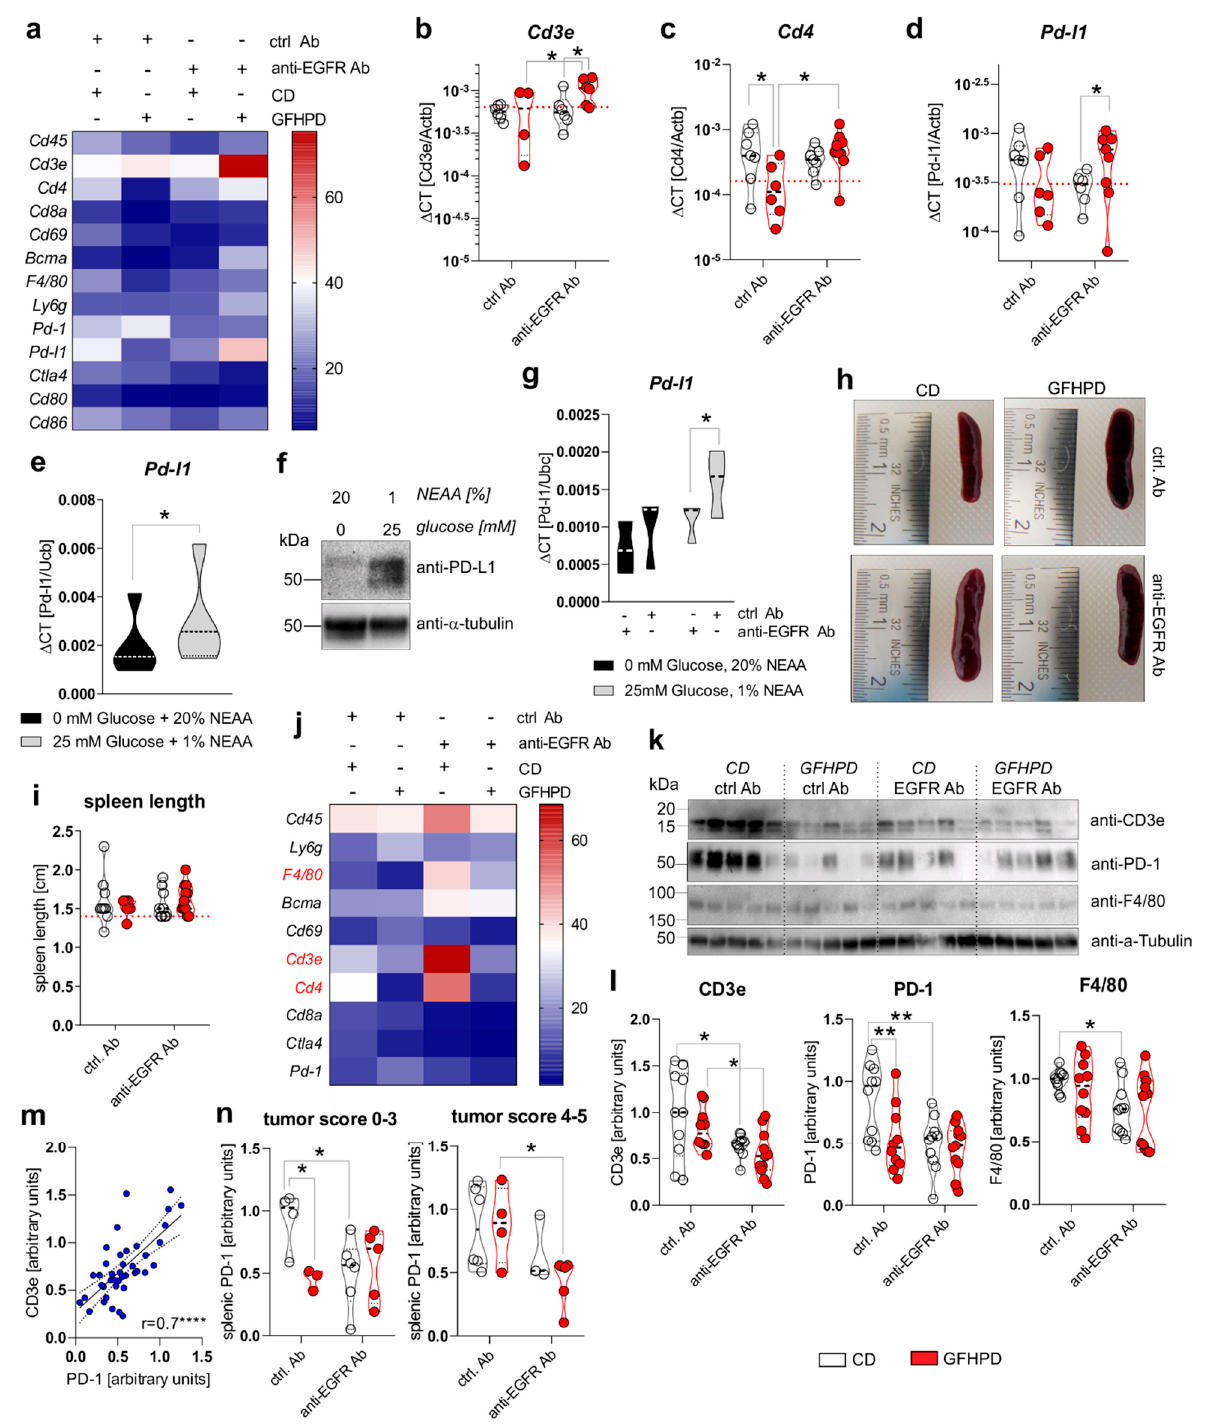
Figure 6. GFHPD and anti-EGFR Ab treatment reduce tumoral Pd-l1 expression and PD-1 expressing T cells. ( a – d ) QPCR analyses were performed to quantify mRNA expression level of Cd45 , Cd3e , Cd4 , Cd8a , Cd69 , Bcma , F4/80 , Ly6g , Pd-1 , Pd-l1 , Ctla4 , Cd80 , or Cd86 in colonic tissues collected from indicated treatment groups of AOM/DSS mice. Results are based on ∆ CT calculation including relation to β -actin mRNA expression. Heatmap was generated based on normalized values (%) per transcript. The mean value per group is presented. n = 6–7 ctrl. Ab and CD; n = 6–7 anti-EGFR Ab and CD; n = 4–6 ctrl. Ab and GFHPD; n = 6–9 anti-EGFR Ab and GFHPD. Red dotted horizontal lines represent respective median values of PBS-treated control mice at day 126. ( e , f ) MC-38 cells were incubated in standard culture medium (25 mM glucose, 1% NEAA) or glucose-free plus 20% NEAA medium for 48 h. ( e ) Pd-l1 mRNA expression was quantified by qPCR experiments and related to Ubc mRNA expression ( n = 5 independent experiments), while ( f ) PD-L1 protein expression was analyzed